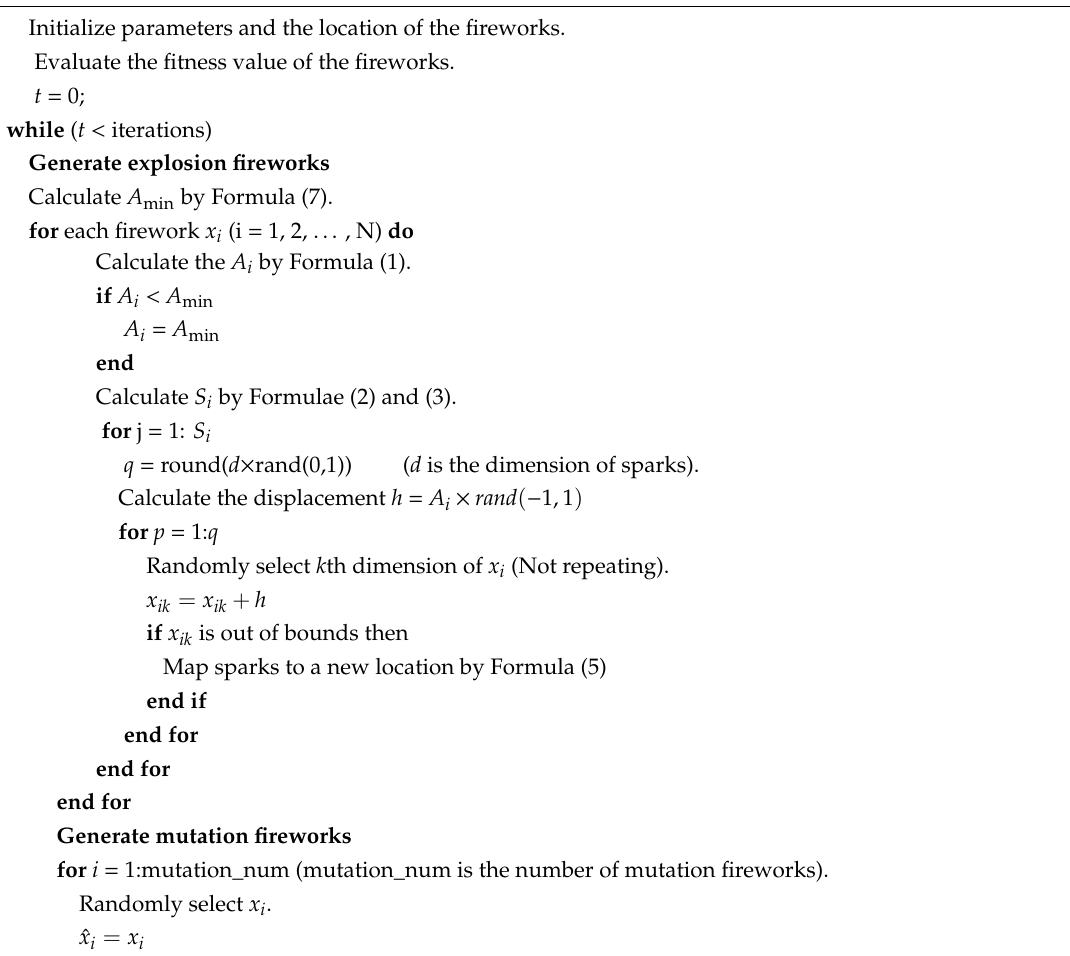
Algorithm 1. The pseudo-code of